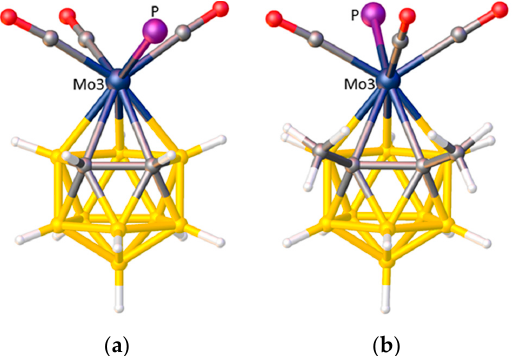
Figure 13. ( a ) The structure of [3,3,3-(CO) 3 -3-PPh 3 - closo -3,1,2-MoC 2 B 9 H 11 ] (Ph groups omitted for clarity) showing the phosphine at low | θ |; ( b ) The structure of [1,2-Me 2 -3,3,3-(CO) 3 -3-PPh 3 - closo -3,1,2-MoC 2 B 9 H 9 ] (Ph groups omitted for clarity) in which the phosphine is displaced to a high | θ | value by steric crowding between it and the cage Me substituents.